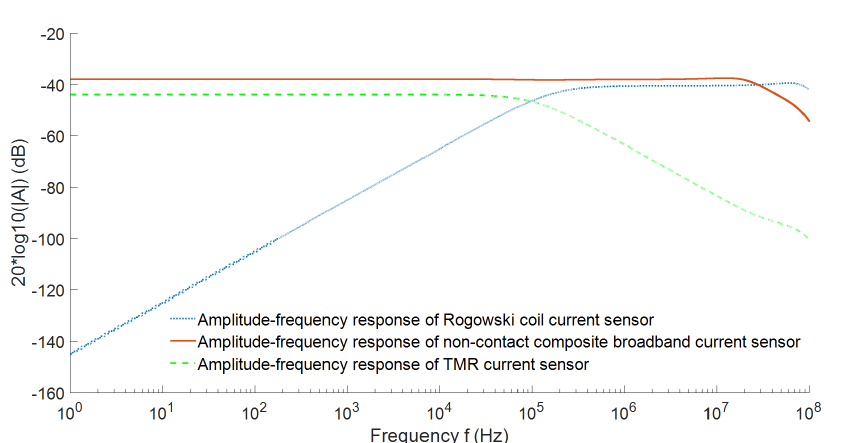
Figure 19. Overall amplitude-frequency characteristics of the non-contact composite wide-bandwidth current sensor.